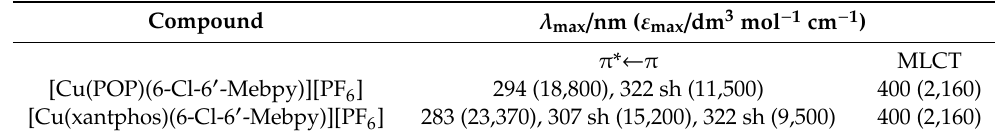
Figure 6. ( a ) The solution absorption spectra of [Cu(POP)(6-Cl-6’-Mebpy)][PF 6 ] and [Cu(xantphos)(6-Cl-6’-Mebpy)][PF 6 ] (CH 2 Cl 2 , 2.5 × 10 − 5 mol dm − 3 ). ( b ) Comparison of the metal-to-ligand charge transfer (MLCT) bands in the solution absorption spectra of [Cu(xantphos)(NˆN)][PF 6 ] with NˆN = bpy [21], 6,6’-Cl 2 bpy [14], 6,6’-Me 2 bpy [11] and 6-Cl-6’-Mebpy. Table 3. Absorption maxima for CH 2 Cl 2 solutions of [Cu(POP)(6-Cl-6’-Mebpy)][PF 6 ] and